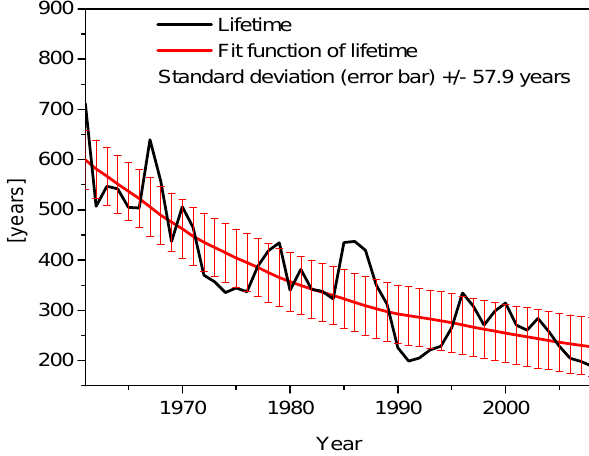
Fig. 1. Globally averaged annual mean of the CO 2 mixing ratio (ppm) in the atmosphere (black line), global annual emission rate of CO 2 per year in billions of tons (green line), and globally averaged annual mean growth rate of CO 2 (ppmyr − 1 ) (red line). The vertical bars indicate the error according to specification of the references. The scale of the emission rate and growth rate has been enlarged by factors 10 and 100, respectively.